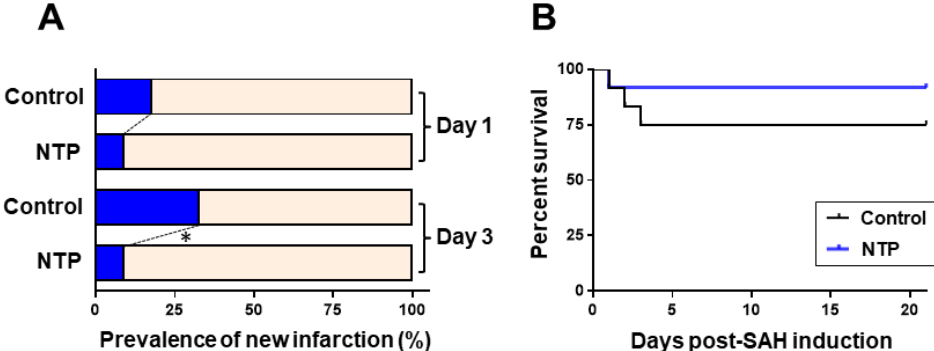
Figure 2. Effects of neurotropin on newly developed cerebral infarction ( A ) and the Kaplan–Meier survival curve ( B ) in mice after-SAH. * p < 0.05; Fisher’s extract test. NTP, neurotropin.